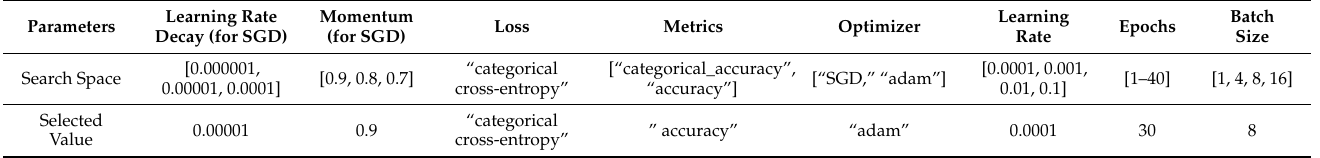
Table 13. Search space and selected values of hyperparameters for